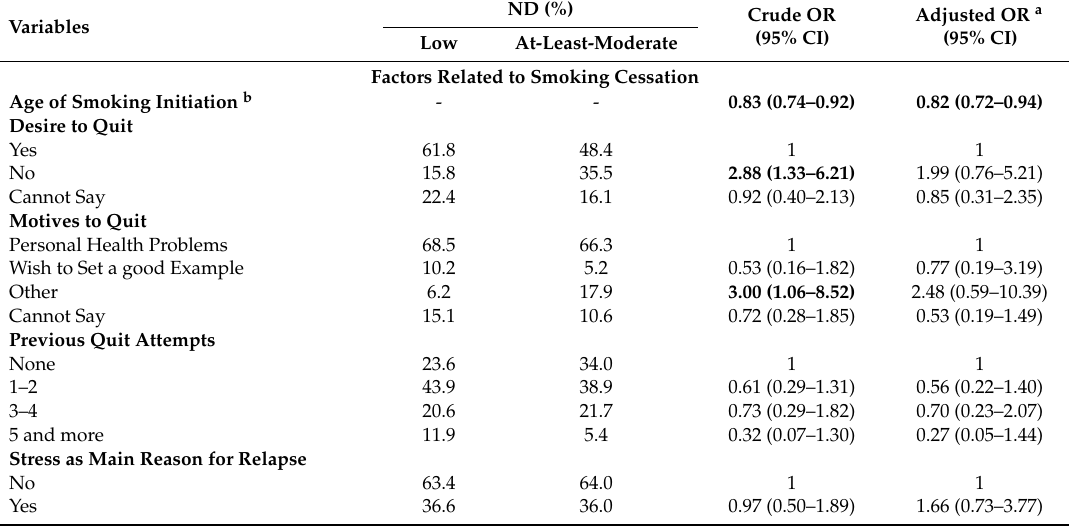
Table 4. Results of logistic regression analysing factors associated with nicotine dependence (ND) (at-least-moderate vs. low) among Estonian physicians smoking daily,